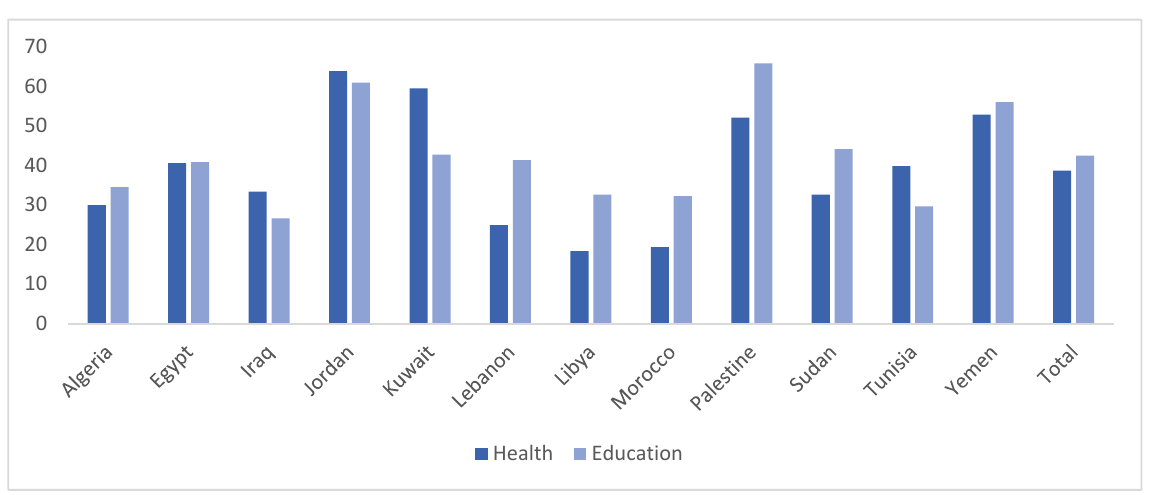
Figure 6. Percentage of people satisfied with health and education systems. Source: Arab Barometer Survey Fifth wave (2018–2019). Available online: https://www.arabbarometer.org/survey-data/data-downloads/ (accessed on 15 July 2021).